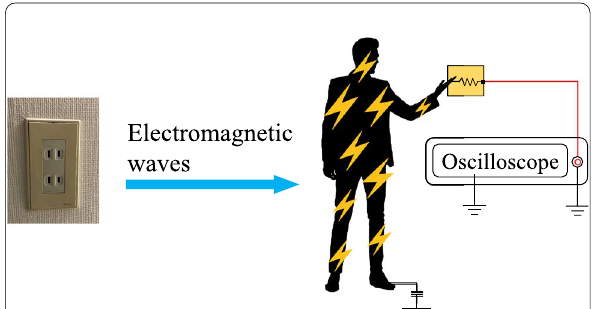
Fig. 1 Principle of HumTouch. HumTouch utilizes the current leaking from a human body when conductive substances in the body react with the electromagnetic waves generated by AC power lines in